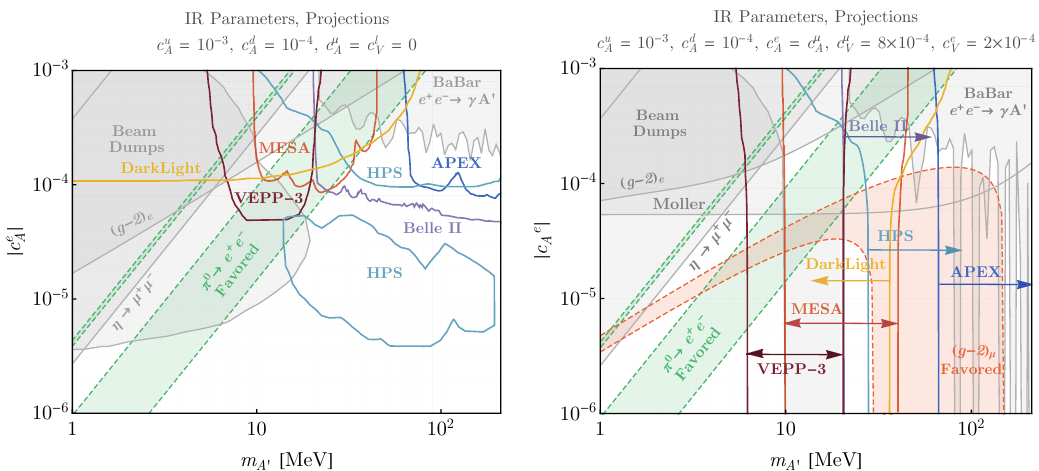
Figure 2 . Projected constraints from various upcoming experiments, corresponding to the param- eter space points shown in (cid:12)gure